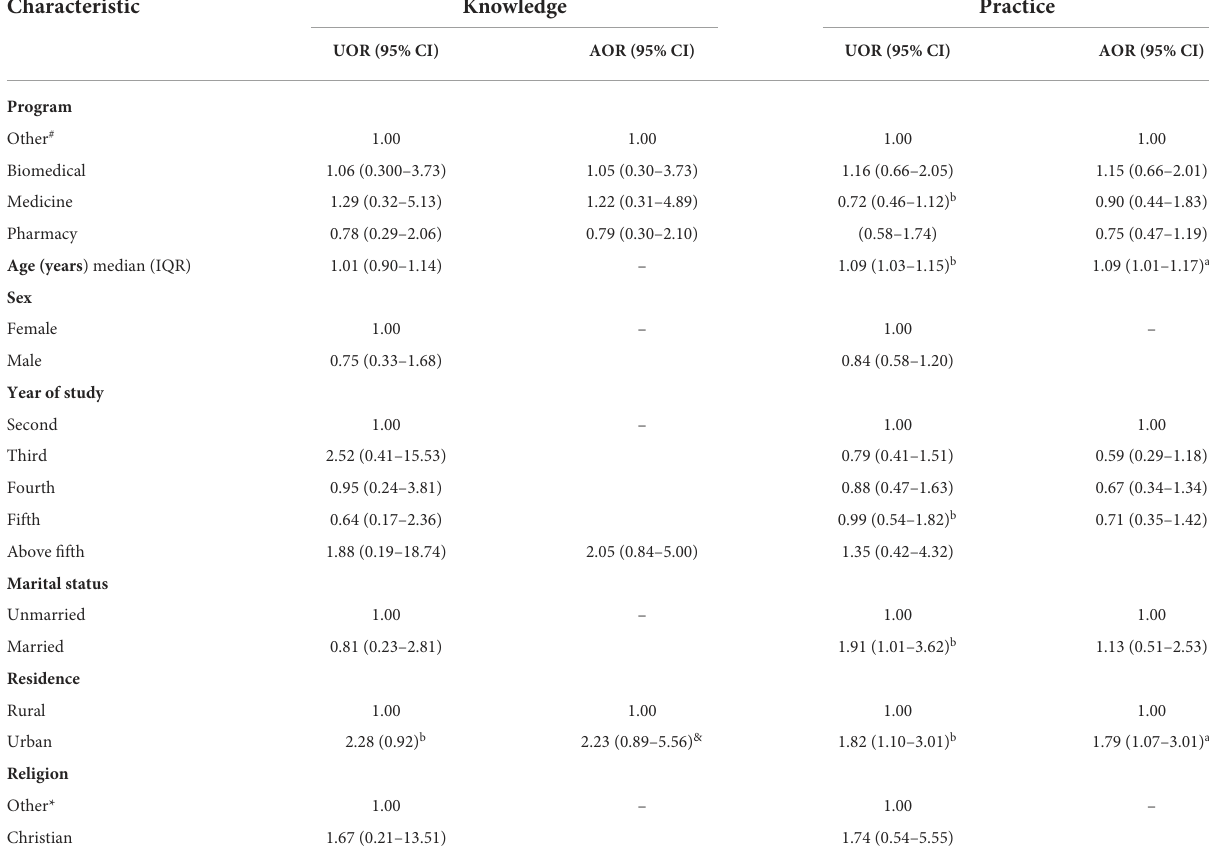
TABLE 4 Simple and multiple logistic regression